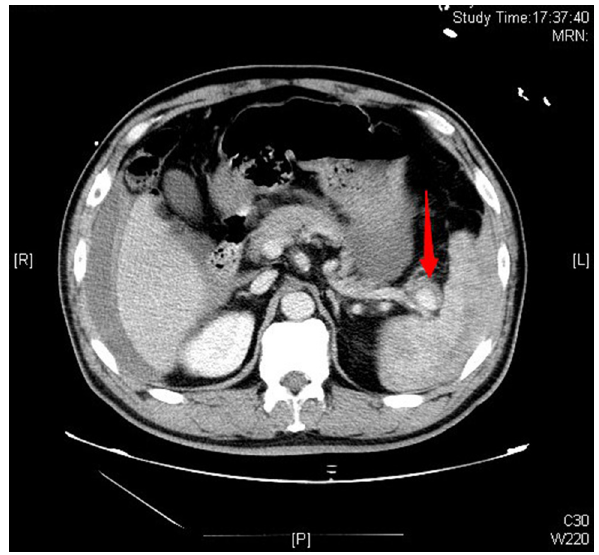
Figure 2: Contrast - enhanced CT of the abdomen showed contrast agent extravasation and ruptured splenic aneurysm ( arrow )